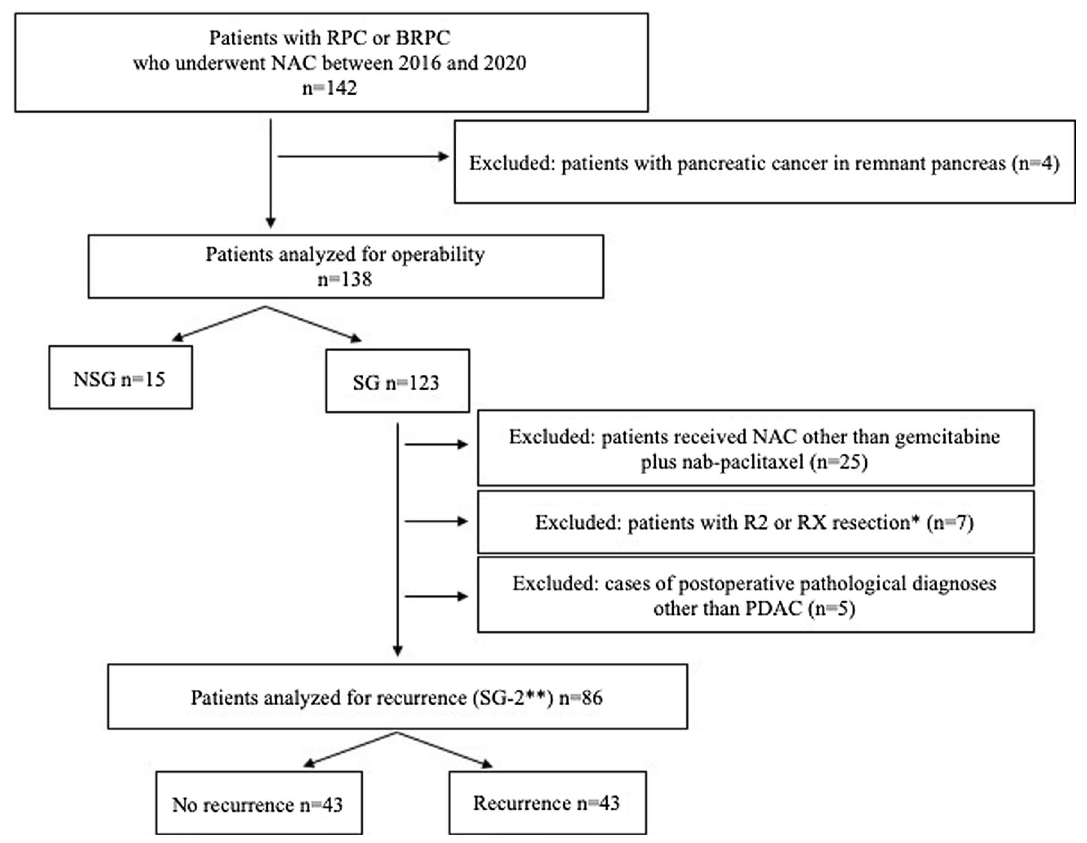
Fig. 1 Algorithms for patient inclusion and exclusion in the present study. Total 138 patients and 86 patients were analyzed for operability and recurrence, respectively. RPC resectable pancreatic cancer, BRPC borderline resectable pancreatic cancer, NAC neoadjuvant